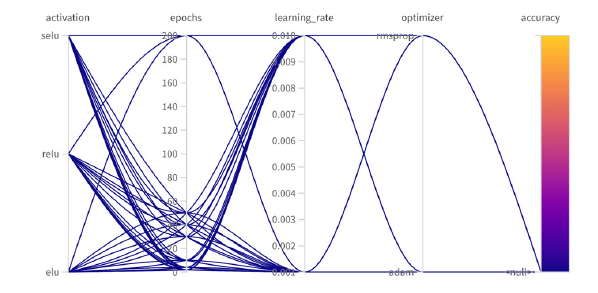
Figure 8. Infograph of the variation of the hyperparameters and the accuracy.